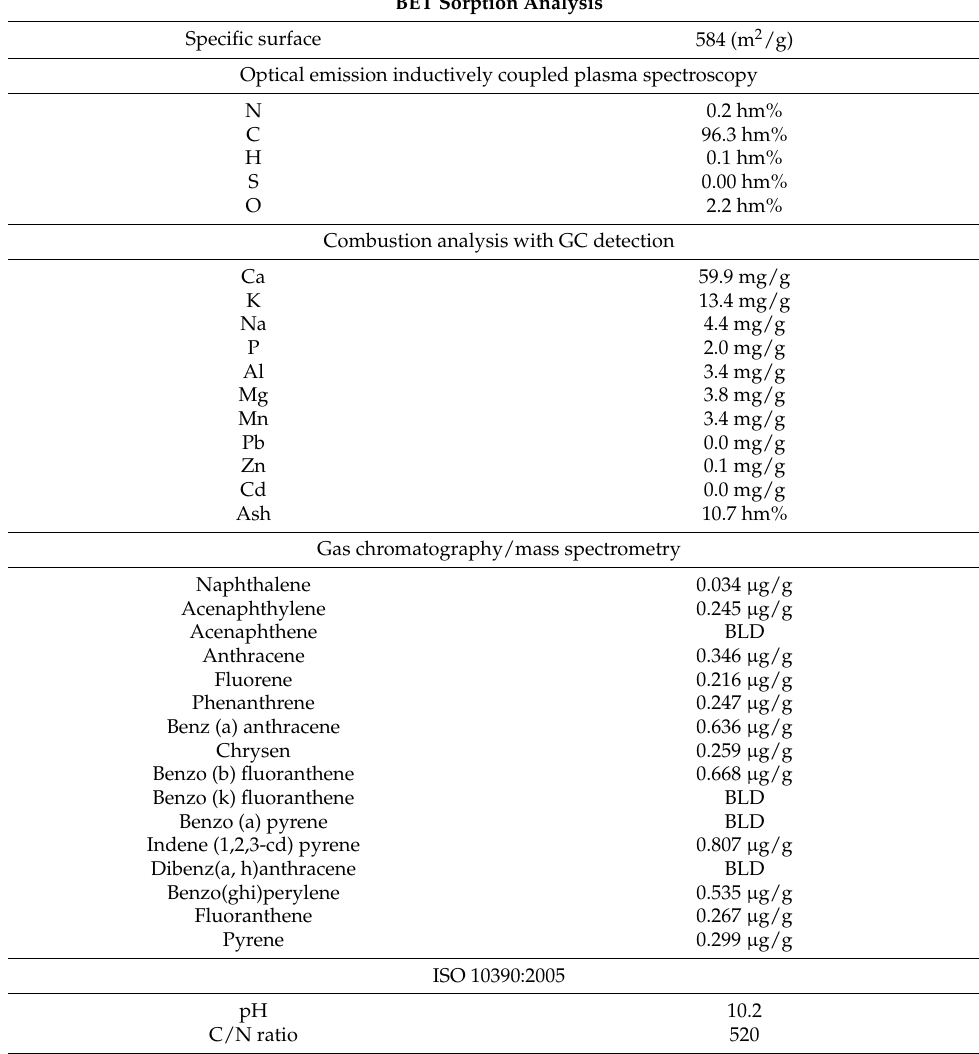
Table 2. Basic properties of the biochar. BET Sorption Analysis Specific